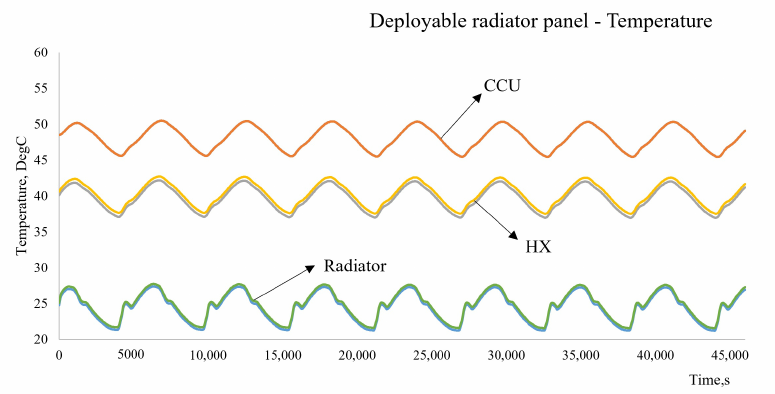
Figure 19. 6U Satellite deployable radiator with heat